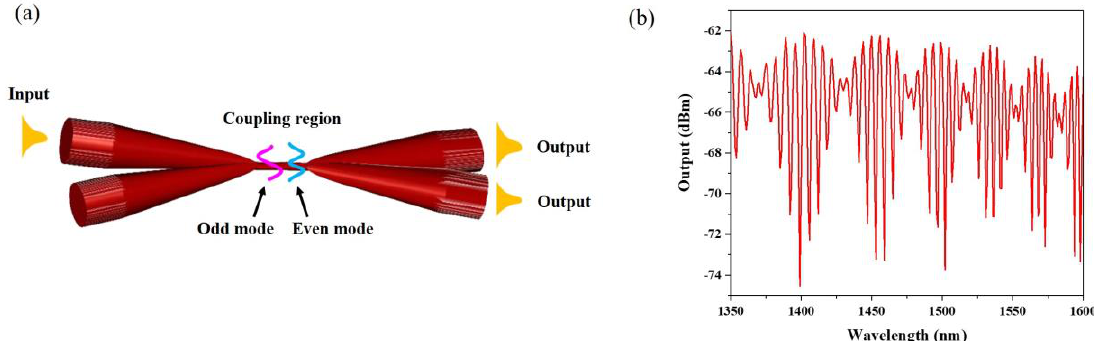
Figure 11. ( a ) Schematic of a MF coupler: two supermodes are excited at the coupler waist region. ( b ) An output spectrum from the MF coupler.